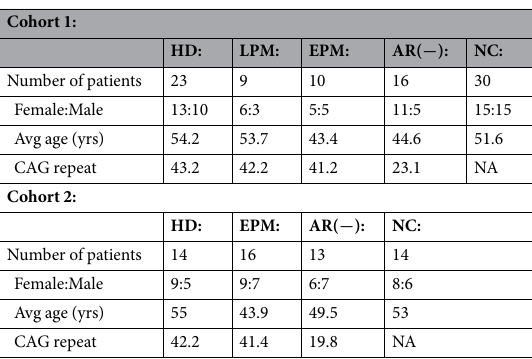
Table 1. Summary of subjects used in this study. HD = Huntington’s disease; LPM = Late pre-manifest; EPM = Early pre-manifest; AR( − ) = At Risk, gene negative; NC = Normal controls. NA = Not applicable. Subjects were comprised of two cohorts of subjects, whose samples were collected approximately 8 months apart. Approximately 20% of the subjects in cohort 2 also gave a sample for cohort 1 but contributed distinct clinical data at each time